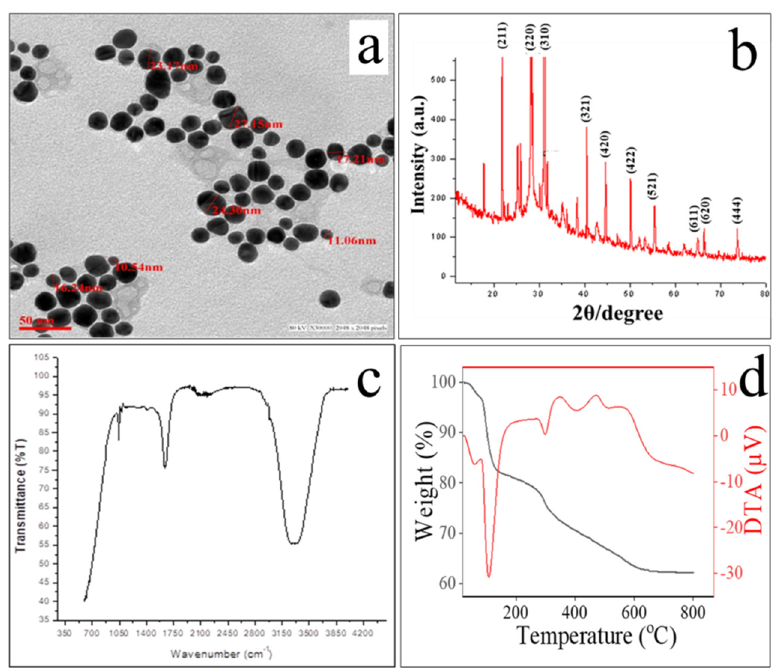
Figure 4. ( a ) TEM, ( b ) XRD, ( c ) FTIR and ( d ) TGA/DTA analysis of biogenic Nd 2 Se 3 NPs.